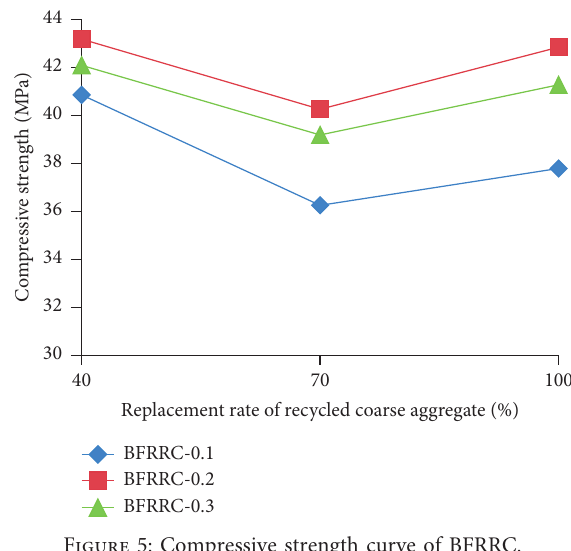
Figure 5: Compressive strength curve of